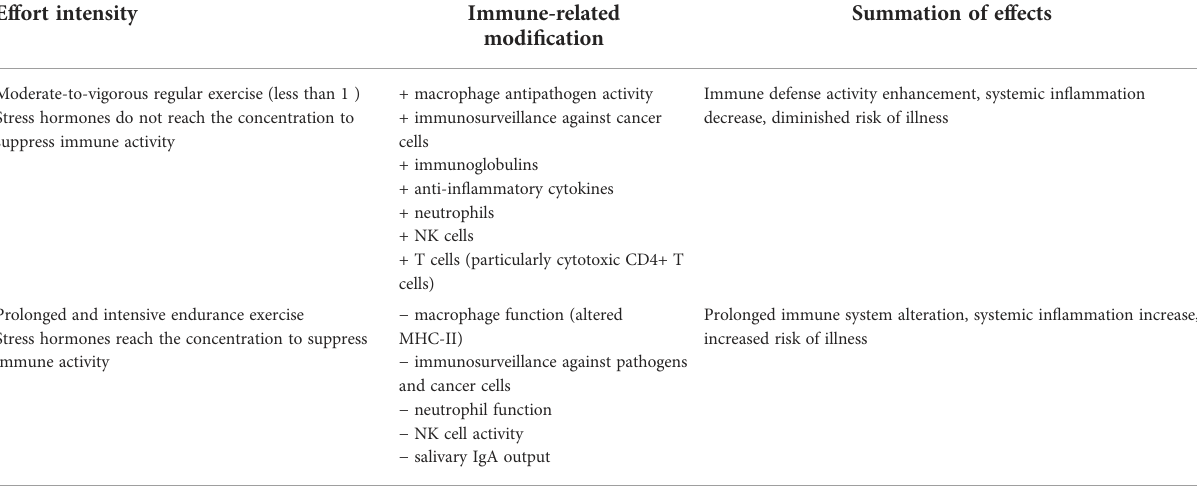
TABLE 1 The effect of effort intensity on immunity. Effort